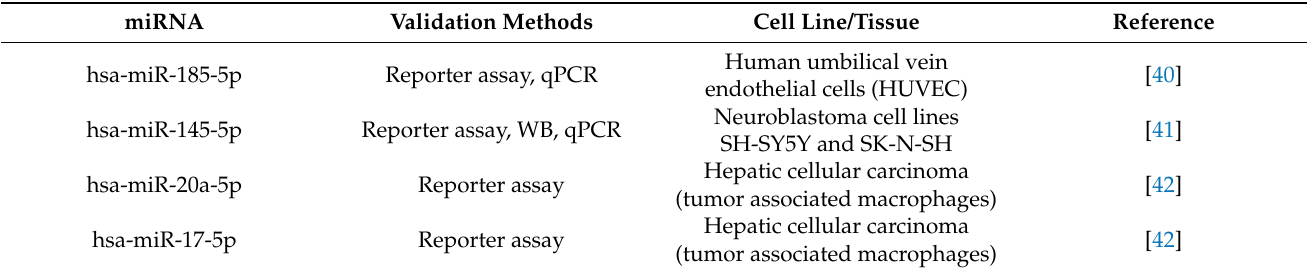
Table 2. The miRNAs confirmed to target human EPAS1 with strong experimental